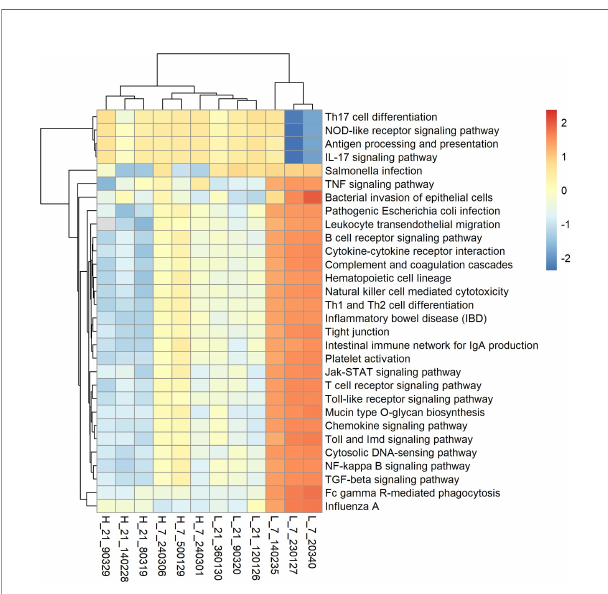
FIGURE 7 | Correlation of cecal microbiota genus with body weight post- infection, H/L ratio and SCFAs concentration in the caecum of SE-infected chickens at 7 and 21 dpi. Turquoise positive correlation; Salmon, negative correlation; *strong correlation (|R| > 0.55, p < 0.05). BW: body weight post- infection; H_L: heterophil/lymphocyte ratio; AC: acetate; PA: propionate; BA: butyrate; VA: valerate. In total 28 biological replicates were used to perform this analysis, including H7_SE: High H/L SE-infected 7 dpi (n = 8), L7_SE: Low H/L SE-infected 7 dpi (n = 7), H21_SE: high H/L SE-infected 21 dpi (n = 6) and L21_SE: Low H/L SE-infected 21 dpi (n = 7). *0.01 < P ≤ 0.05, **0.001 < P ≤ 0.01, ***P ≤